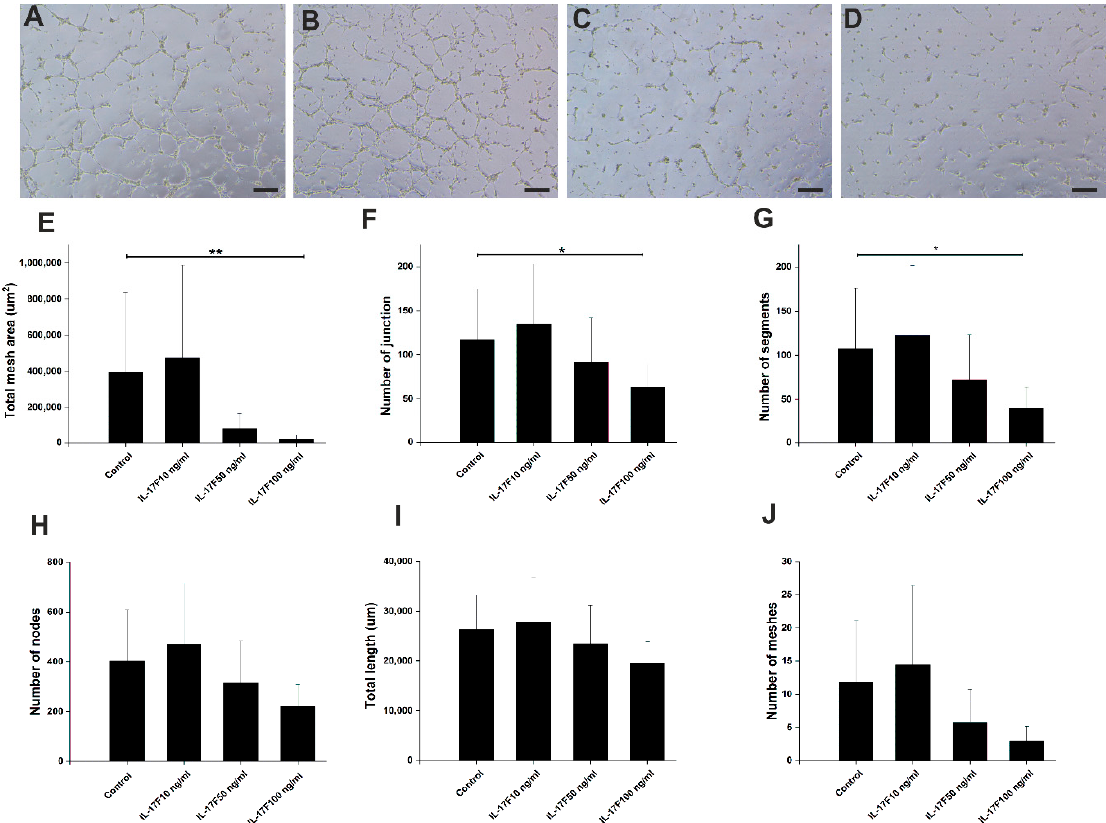
Figure 7. IL-17F inhibits endothelial tube formation in a dose-dependent manner. ( A ) Non-treated human umbilical vein endothelial cells (HUVEC) form clear interlaced tubes when cultured on Matrigel-based matrix. Scale bar = 100 µm. ( B ) 10 ng/mL of IL-17F partially suppressed HUVEC tube formation. ( C ) 50 ng/mL IL-17F induced more inhibition of tube formation. ( D ) A higher dose of IL-17F (100 ng/mL) showed almost complete inhibition of tube formation in HUVEC. ( E ) Morphometric analysis of HUVEC demonstrates that IL-17F reduced the total mesh area ( p = 0.009, 100 ng/mL). ( F ) IL-17F also reduced the number of junctions ( p = 0.04, 100 ng/mL). ( G ) IL-17F reduced the number of segments ( p = 0.02, 100 ng/mL). ( H ) IL-17F reduced the number of nodes. ( I ) IL-17F reduced the total length. ( J ) IL-17F reduced the number of meshes. Data are presented as means ± standard deviations. * p ≤ 0.05, ** p ≤ 0.01.